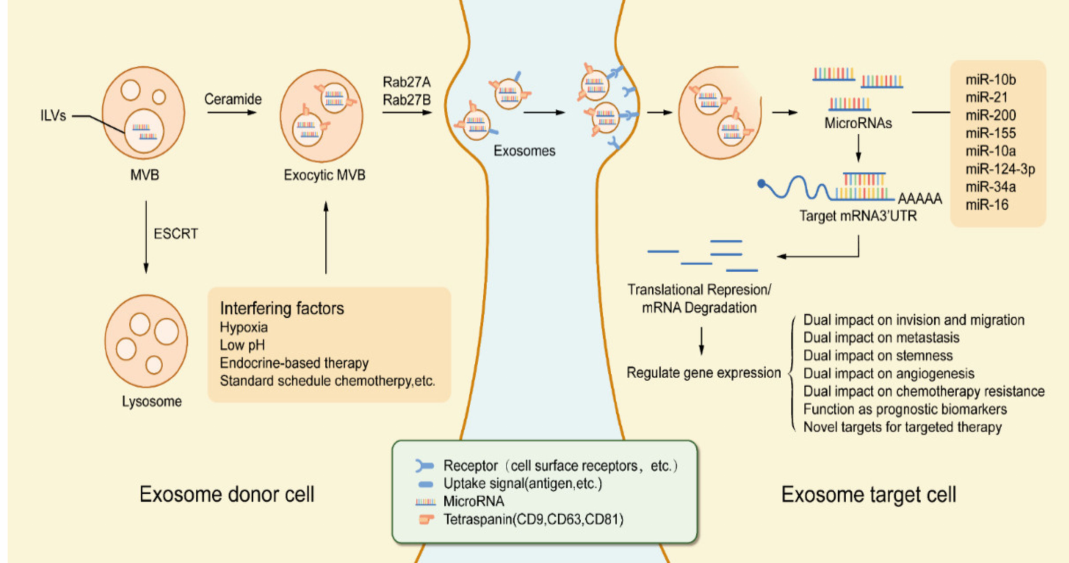
Figure 2. Tumor regulation process based on exosomal miRNA in the tumor microenvironment. Exosomes are derived from MVB which germinate inward in the form of ILVs. The formation of exosomes as well as the sorting of cargo into lysosomes involves the ESCRT. In addition, exosome production and secretion are also completed by a non-ESCRT dependent process that involves the sphingolipid ceramide and the enzyme neutral sphingomyelinase. Stimulation by various types of chemical, physical factors can induce the secretion of exosomes, such as hypoxia, low pH, endocrine therapy, etc. After the fusion of MVBs with the cell membrane, exosomes are secreted into the extracellular space under the action of Rab GTPases (Rab27A, Rab27B). Exosomes released from exosome donor cells (tumor cells, etc.) will exhibit similar receptor ligands or antigens as their cells of origin. The endocytic process of exosomes occurs with the activation of receptors or bioactive lipid ligands at the cell surface. After exosomes are endocytosed by exosome target cells (endothelial cells, etc.), miRNAs in exosomes are released. Transferred miRNAs are bioactive and can regulate gene expression in exosomal target cells through post-translational regulation of mRNA expression, which in turn leads to mRNA instability or degradation. miRNA-dependent gene regulation can affect various types of processes involved in tumorigenesis and development, and changes in gene expression levels can also be used as a marker for judging tumorigenesis and progression. Abbreviations: MVB: multivesicular body; ILVs: intraluminal vesicles; ESCRT: endosomal sorting complex required for transport; Rab27A: Ras-associated binding 27A; Rab27B: Ras-associated binding